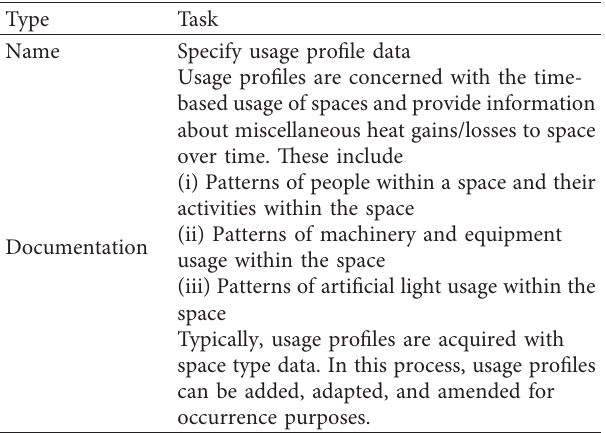
Table 3: Process specification in the process